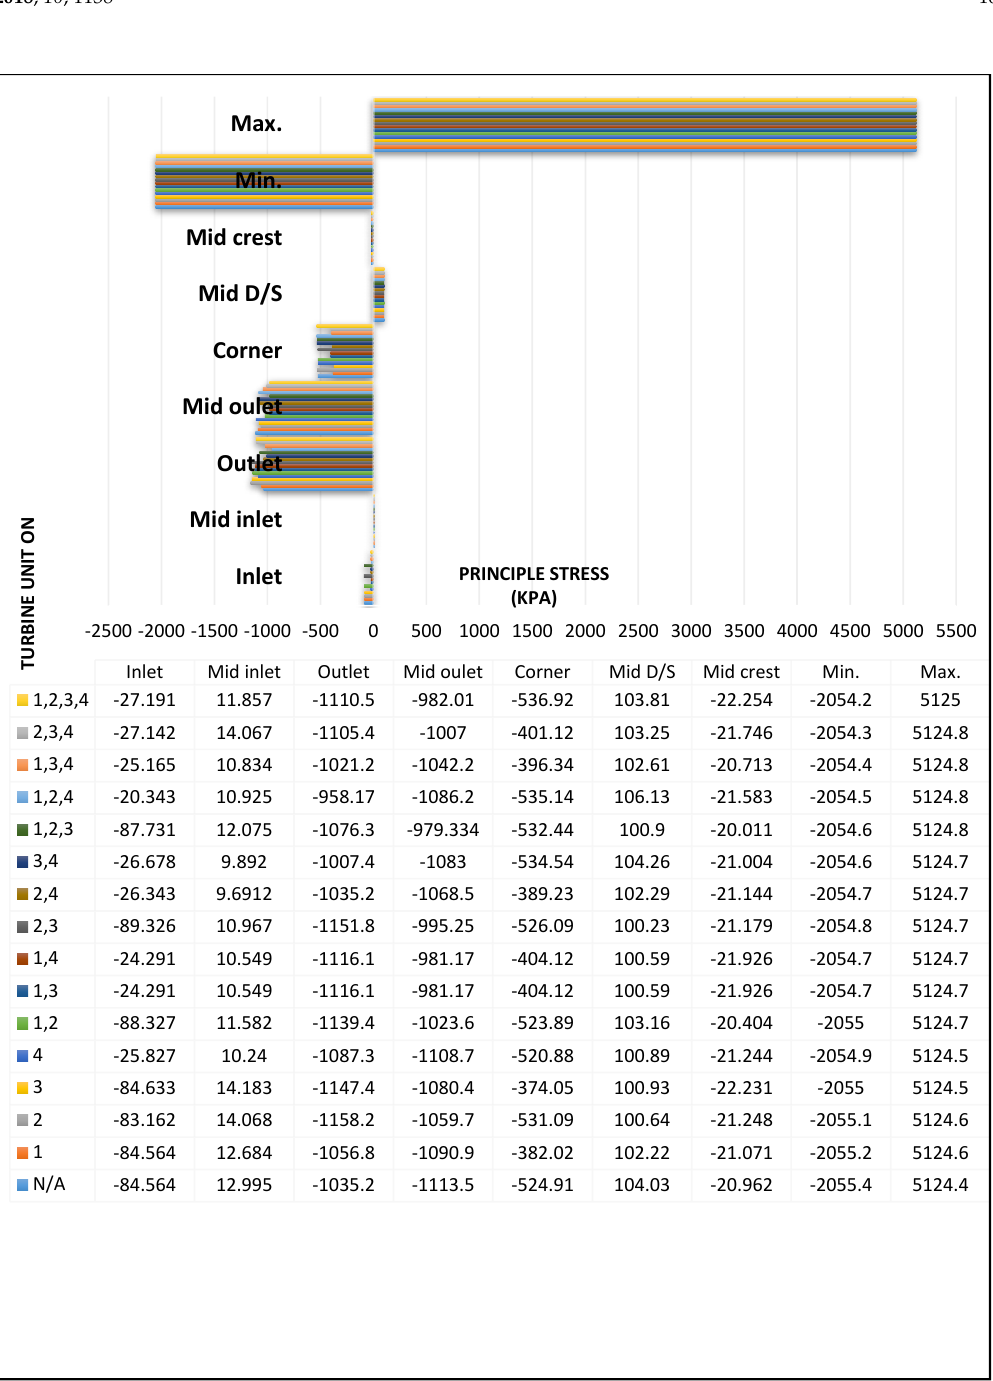
Figure 15. The principle stress values in the selected points of Temenggor dam body according to running turbine units in maximum water. Table 7. Statistical analysis of the principle stress results at the minimum upstream water level.